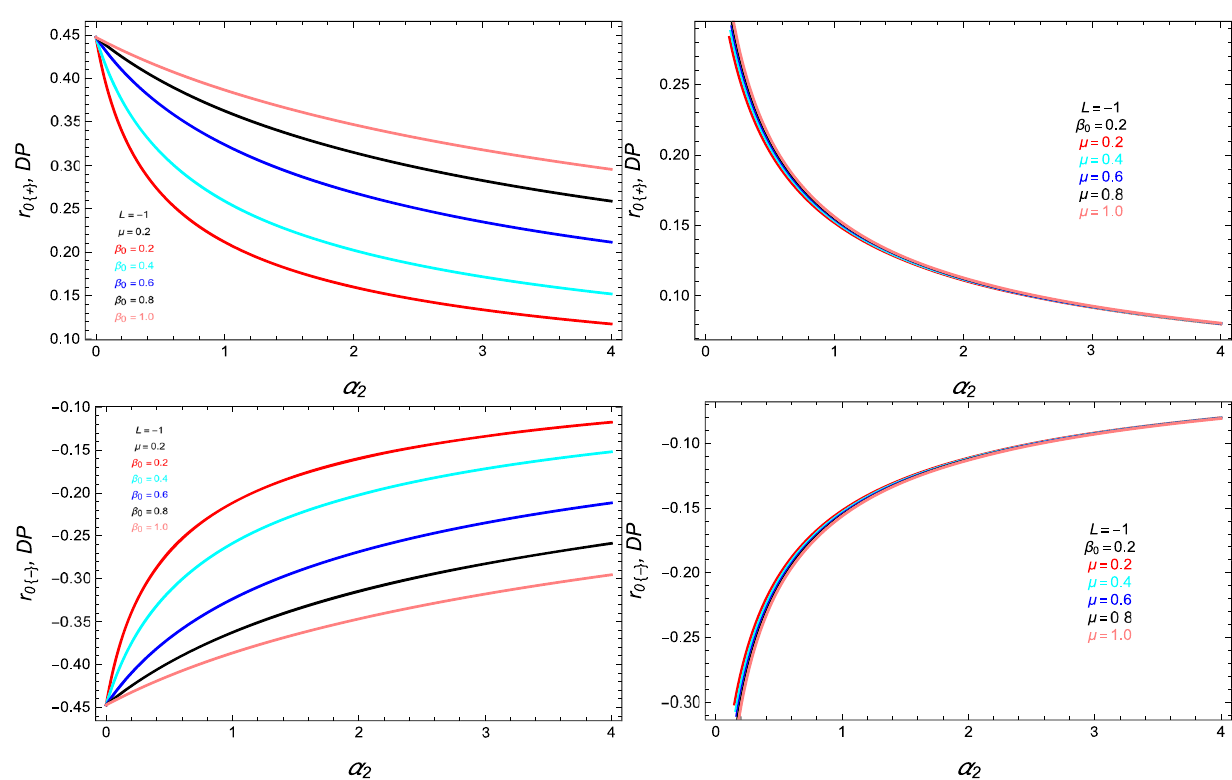
Fig. 3 Positive and negative divergence points (DP) r 0 {+} , and r 0 {−} (up and down) plots along α 2 for by fixing L = − 1 , μ = 0 . 2 for different values of β 0 {left panel} and positive and negative divergence